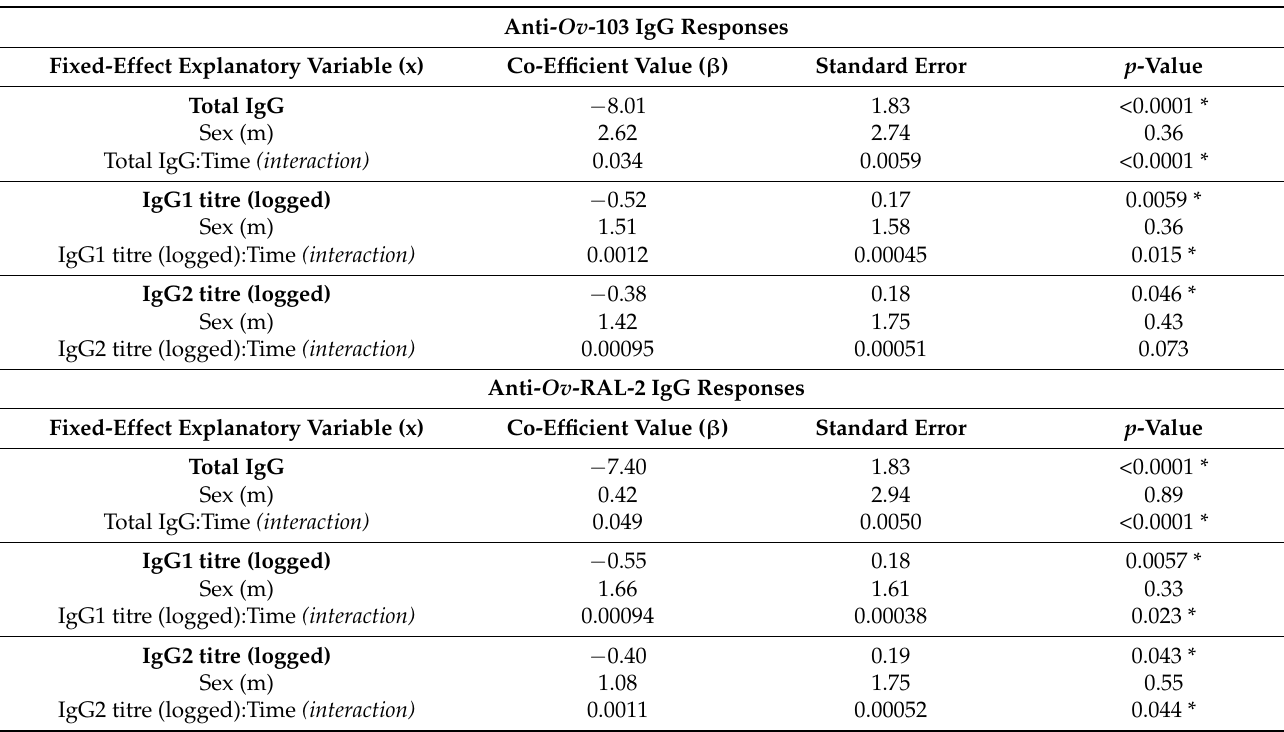
Table 6. Multivariable linear mixed effects regression analysis results investigating correlations between female worm nodule burdens (response variable “Y”) and antigen-specific serum IgG responses in vaccinated calves post-exposure nodule antibody responses in vaccine efficacy trial over immunisation period